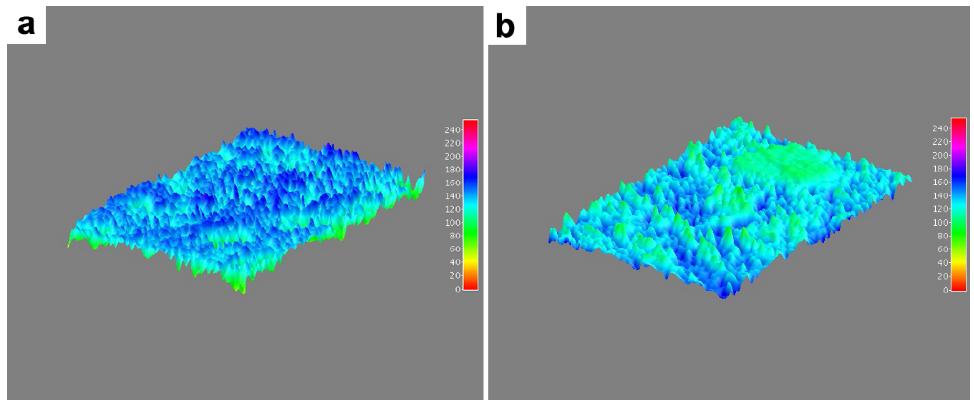
Figure 8. 3D projection in rainbow trout ( Oncorhynchus mykiss ) jawbone microstructure. ( a ) Farmed fish. ( b ) Wild fish. Chemical contrast detector (BSD) image, 1000× magnification. ImageJ software